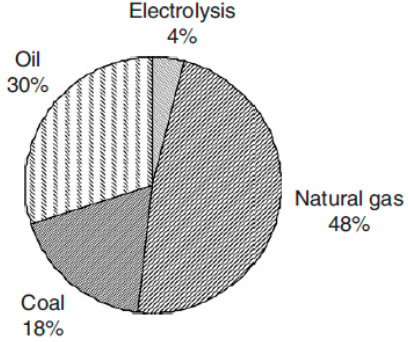
Figure 1. Distribution of feedstock for hydrogen production (Adapted from ref. [13]).